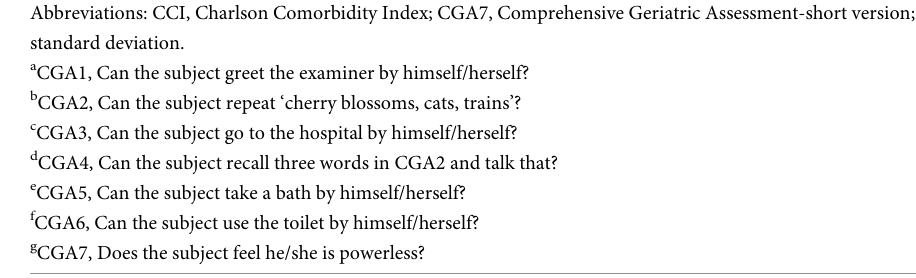
(Table 5). Regarding surgical clinical variables (Table 6), the separate incidences of POD and SSD were significantly associated with the postoperative use of sleeping pills ( p = 0.022), physi- cal restraint use ( p = 0.001), and bed sensor use ( p < 0.001). Risk factors for POD and SSD determined using binary logistic regression analysis The binary logistic regression analyses of both POD and SSD as the primary analysis were car- ried out with the key independent variables in each of the seven CGA7 items. However, the